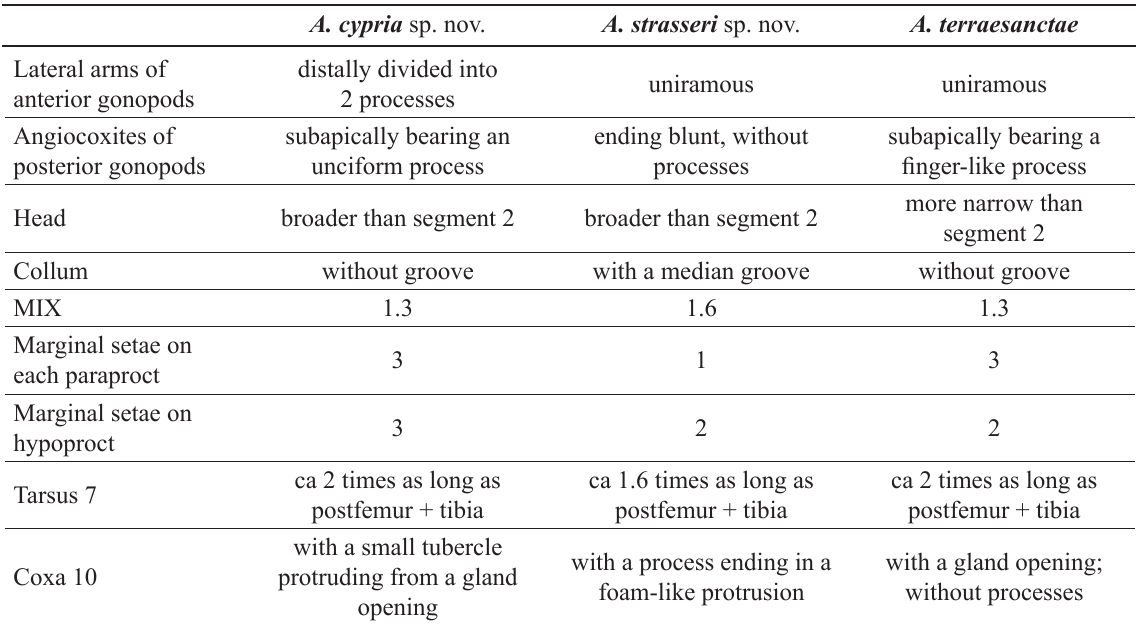
Table 1. Diagnostic characters of Anamastigona cypria sp. nov., A. strasseri sp. nov. and A. terraesanctae Golovatch & Makarov,